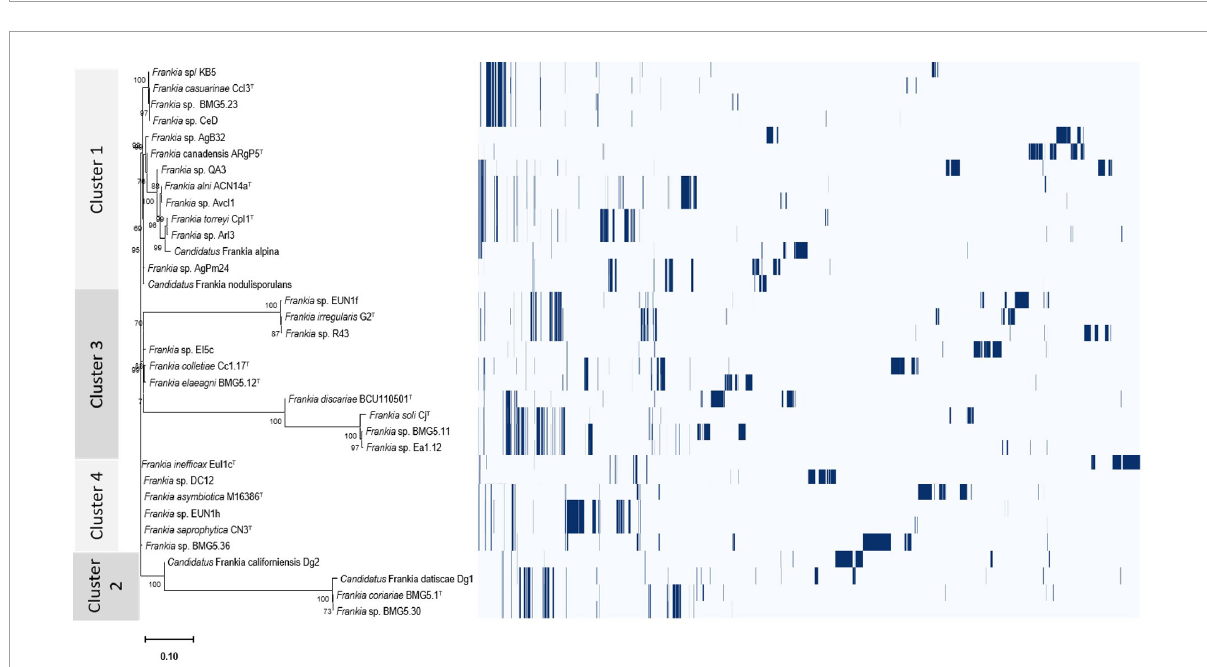
FIGURE5 Roary plot showing the tree compared to a matrix with the presence and absence of core and accessory genes identified for the four cluster